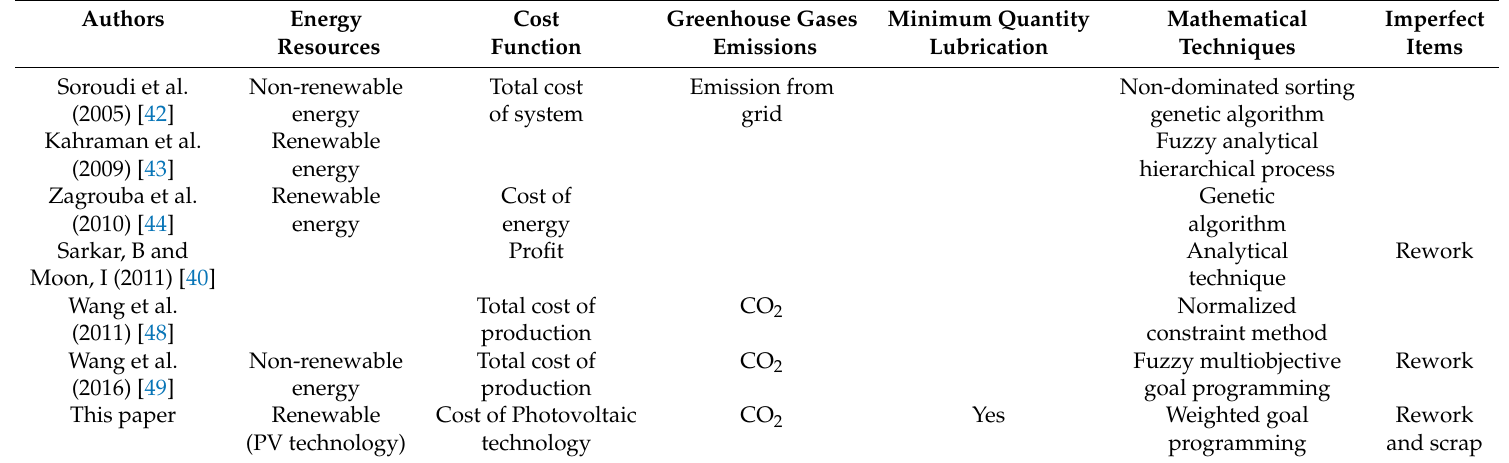
Table 2. Author contribution